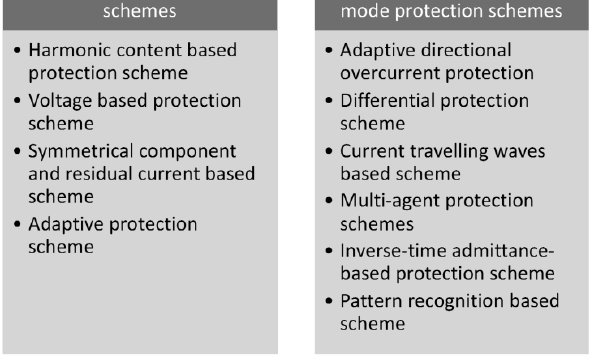
Figure 3. Protection schemes (rewritten from [23]).